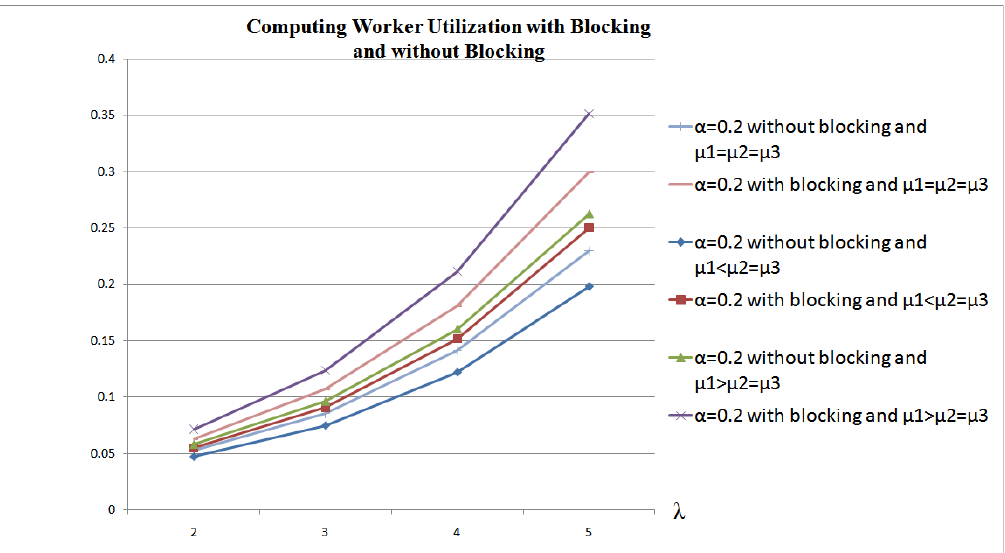
Figure 6. Comparison of Computing Worker CPU Usage in 3 scenarios: (1) (cid:22)